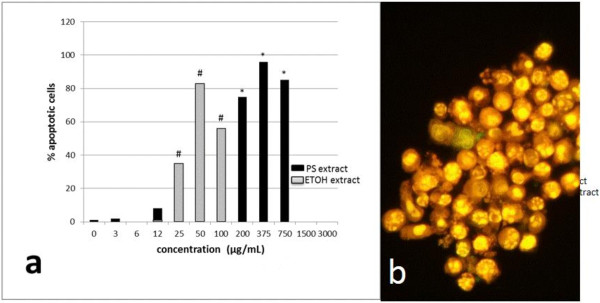
Concentration-dependent induction of apoptosis in THP-1 cells. Cells were cultivated for 24 h in the presence of different concentrations of partially purified P. linteus polysaccharide extract, respectively of ethanol extract of P. linteus. Cells were collected by centrifugation, fixated in 4% buffered formaldehyde and stained by AO/EB. A minimum of 500 cells was counted per point. Observation at excitation/emission at 485/530 nm, using a 20× objective. (a) Dose effect graph. (b) Microphoto of THP-1 cells treated by 375 μg P. linteus polysaccharide extract/mL medium. * and #P < 0.05, significantly different from the previous values of the same concentration range.